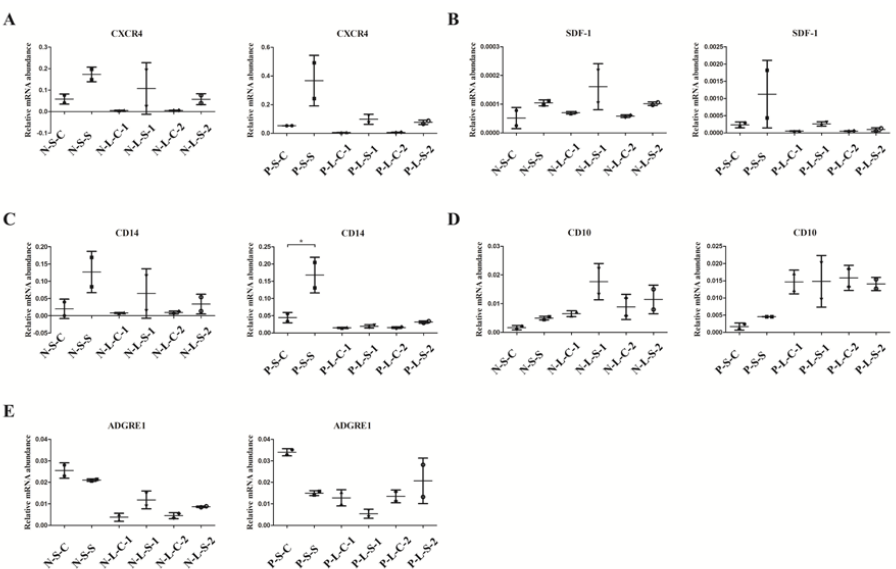
Figure 4. Gene expression in vitro demonstrating the positive relationship between CD14 and CXCR4. ( A - C )ThegeneexpressionofCXCR4( A )andSDF-1( B )showedsimilartrendstothatofCD14( C ).Short-term cultured BMCs showed increased CD14 expression in PAH rats, while long-term cultured BMCs did not ( C ). ( D , E ) The gene expression of CD10 ( D ) and ADGRE1 ( E ) did not show similar trends to those of CXCR4 ( A ) and SDF-1 ( B ). N-S-C: normal-short-control culture, N-S-S: normal-short-silibinin culture, N-L-C-1: normal-long-control 1 culture, N-L-S-1: normal-long-silibinin-1 culture, N-L-C-2: normal-long-control 2 culture, N-L-S-2: